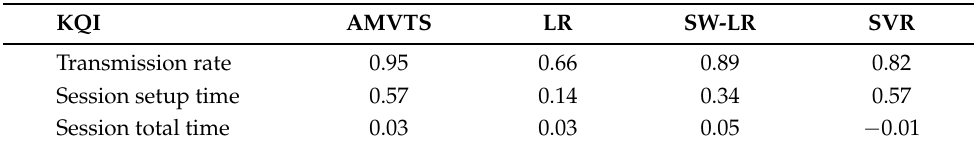
Table 4. Comparison with other linear regression techniques using the R 2 performance metric (results from Herrera-Garcia et al. [1]). AMVTS, adaptive multivariate time-series; SW-LR, stepwise linear